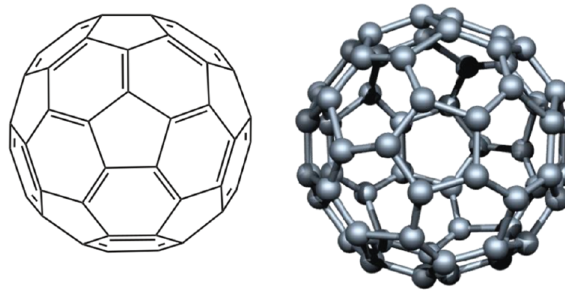
Figure 4: Schematic representation (2D and 3D) of the fullerene structure C